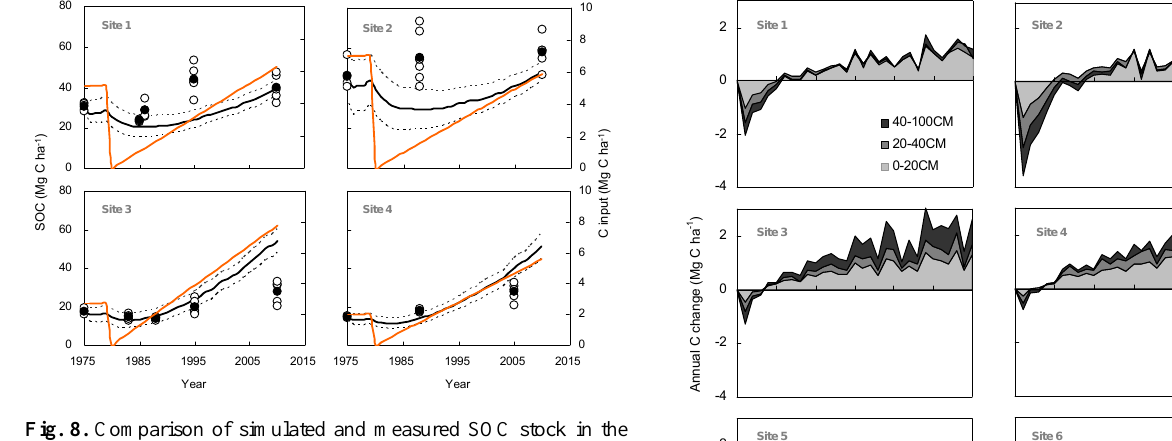
Fig. 8. Comparison of simulated and measured SOC stock in the 0–100cm soil depths following afforestation. Figures are not shown for sites 5 and 6 due to missing SOC data for 60–100cm soil depths. All other designations are the same as those in Fig. 6.